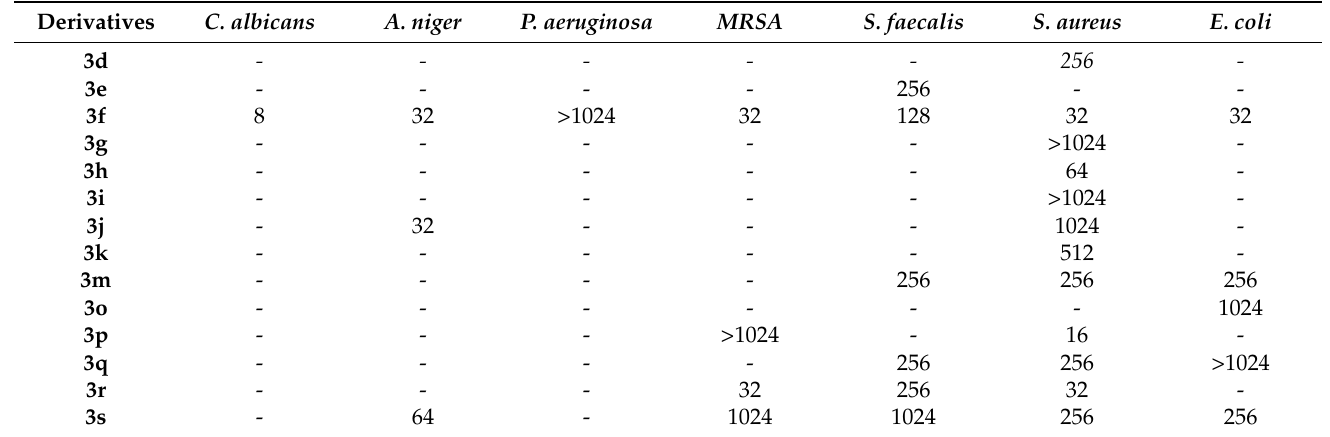
Table 5. MIC of the antifungal and antibacterial effects of derivatives 3d , 3e , 3f , 3g , 3h , 3i , 3j , 3k , 3m , 3o , 3p , 3q , 3r , and 3s , ( µ